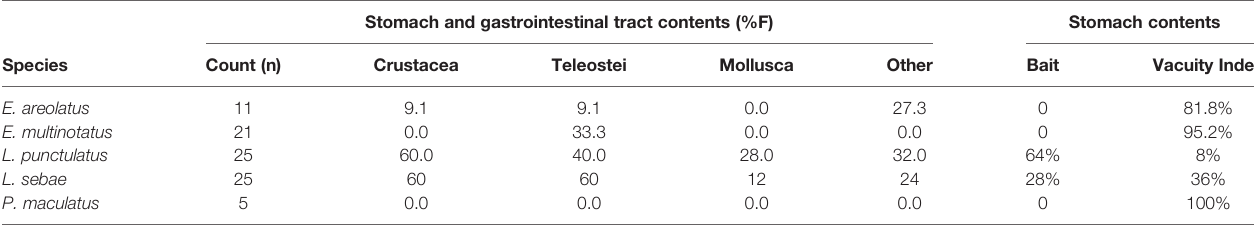
TABLE 3 | Summary of stomach and gastrointestinal tract contents of predatory fi shes.